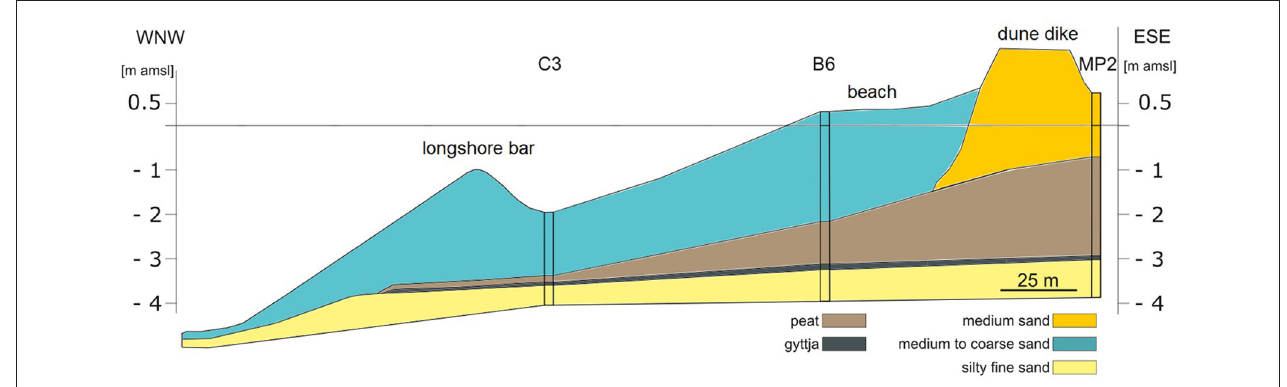
FIGURE 7 | Geological profile perpendicular to the coast with drilling locations (MP2, B6, C3—compare Figure 1 for core locations) with sediment depths in m amsl. The information of sub-sedimentary peat continuation is based on ground truthing with core C3 and the continuation of internal reflectors in the seismic